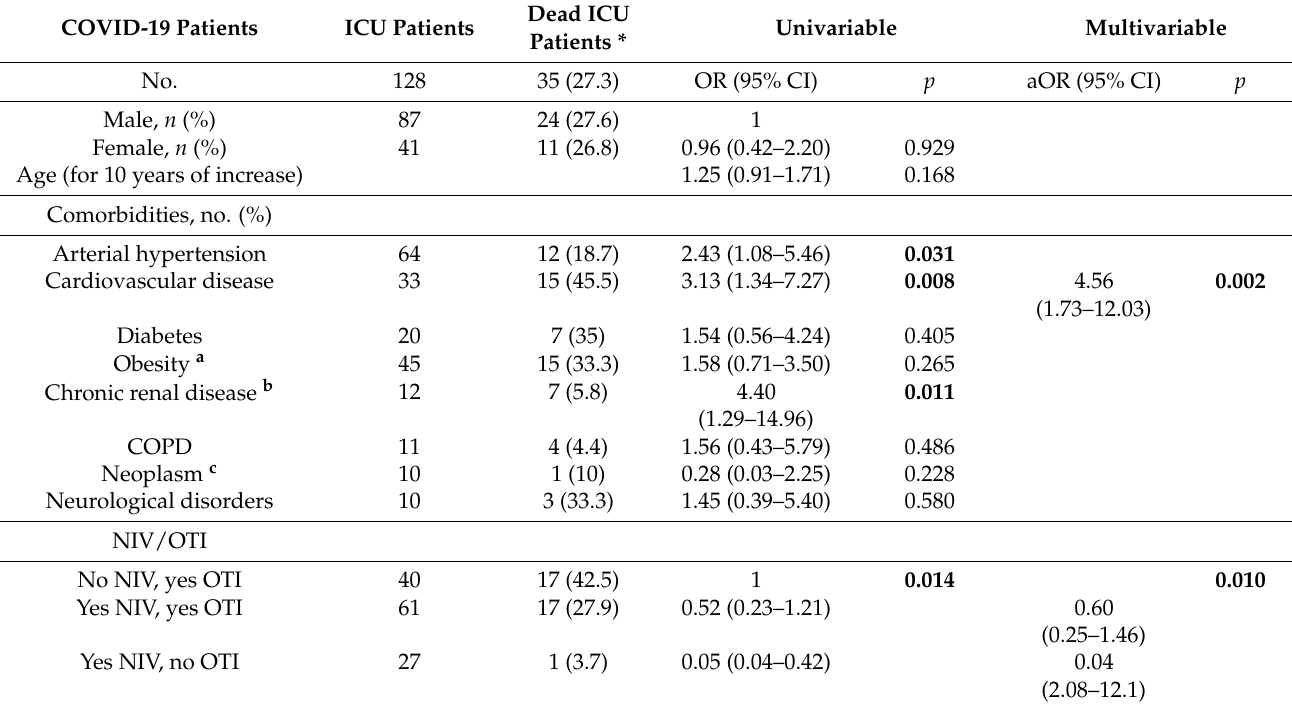
Figure 3. Flowchart of patients admitted into ICU. Abbreviations: NIV, noninvasive ventilation; ICU, intensive care unit; OTI, orotracheal intubation. Table 3. Multifactorial analysis of the factors associated with an outcome of death.